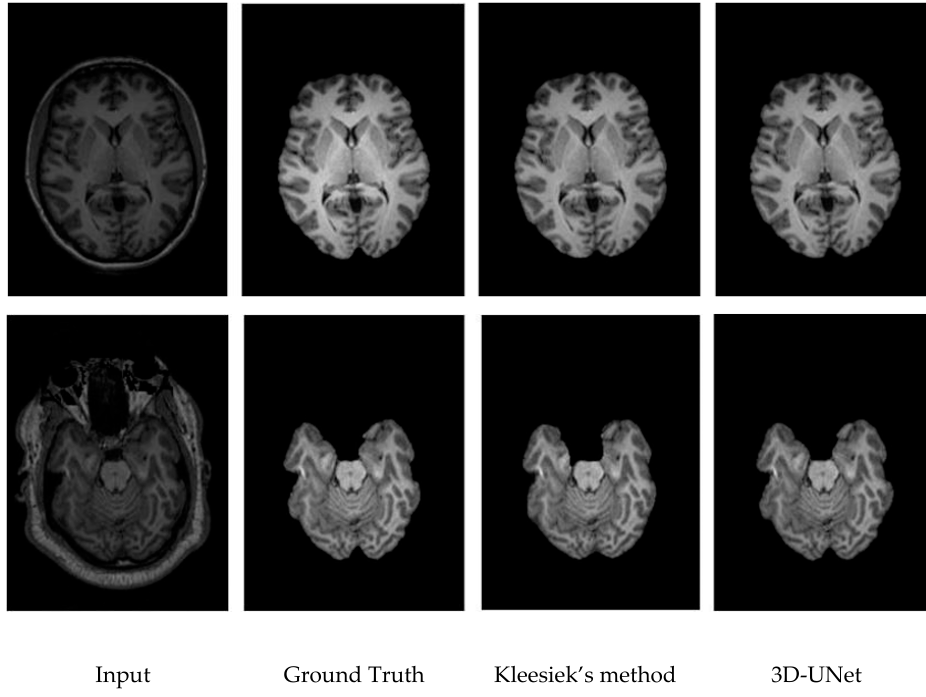
Figure 7. Qualitative performance comparison of 3D-UNet with Kleesiek’s method.